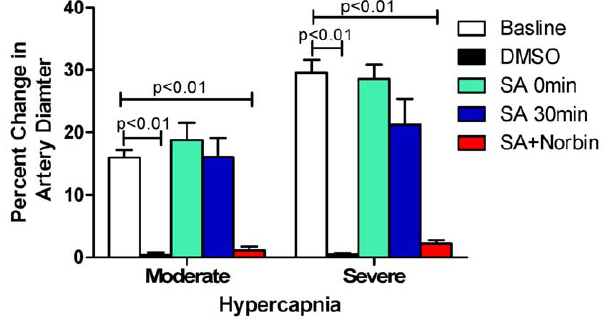
Figure 1. Effects of post HI salvinorin A administration on pial artery dilation to hypercapnia. HI with DMSO impaired dilation of pial artery to hypercapnia. SA administrated at onset and 30 min after HI preserved the dilation of pial artery to moderate and severe hypercapnia, which were blunted by norbinaltorphimine (Norbin). N=5 in each group. Percentage change= (diameter after hypercapnia 2 dia- meter before hypercapnia)/diameter before hypercapnia)*100. SA: Salvinorin A; Moderate: hypercapnia with PaCO 2 of 50 to 60 mmHg; Severe: hypercapnia with PaCO 2 of 70 to 80 mmHg.